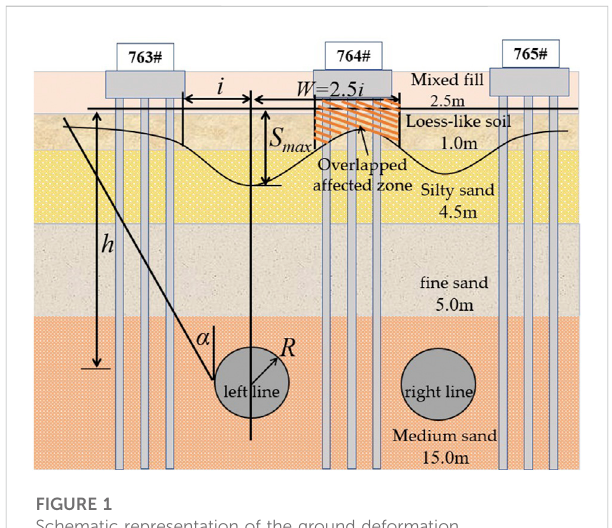
FIGURE 1 Schematic representation of the ground deformation mechanism of tunnel